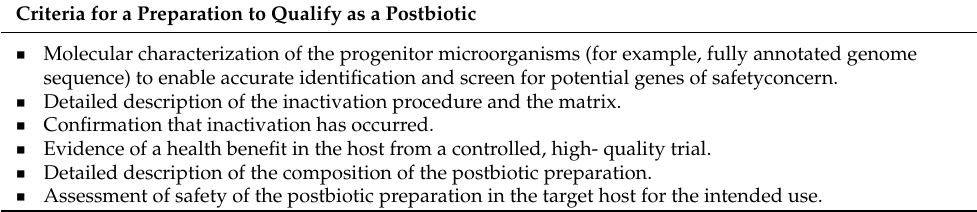
Table 4. Criteria for a preparation to qualify as a postbiotic Salminem et al. [144].